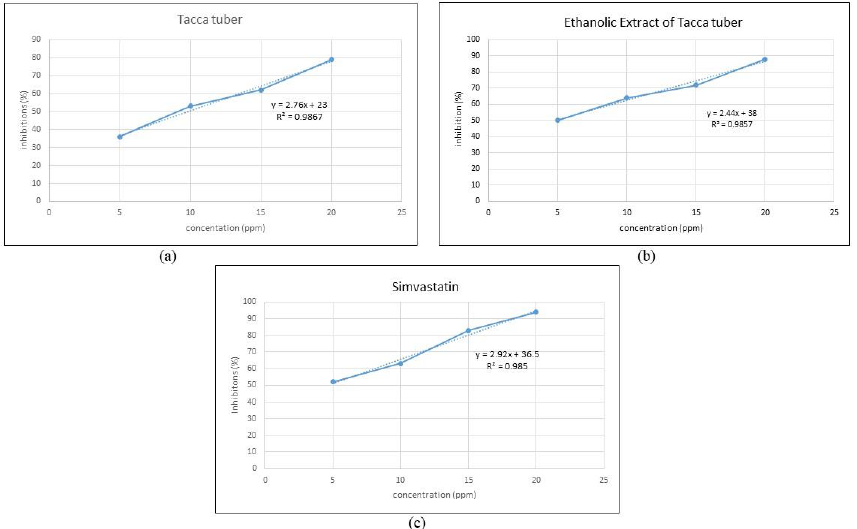
Figure 5. Inhibitory activity of HMG-CoA reductase of Tacca tuber ( a ), ethanolic extract of Tacca tuber ( b ) and simvastatin ( c ).